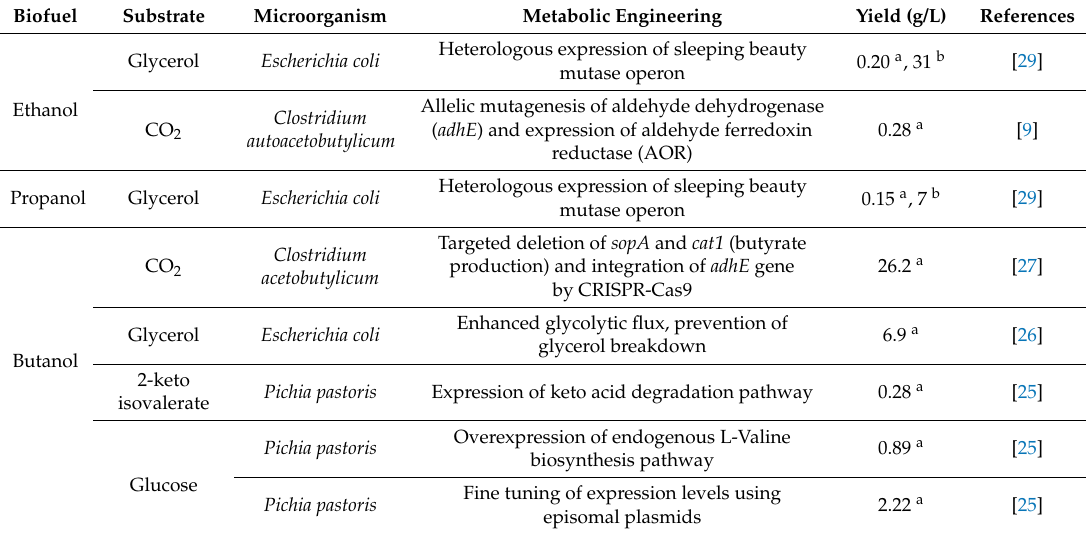
Table 1. Biofuel production in engineered